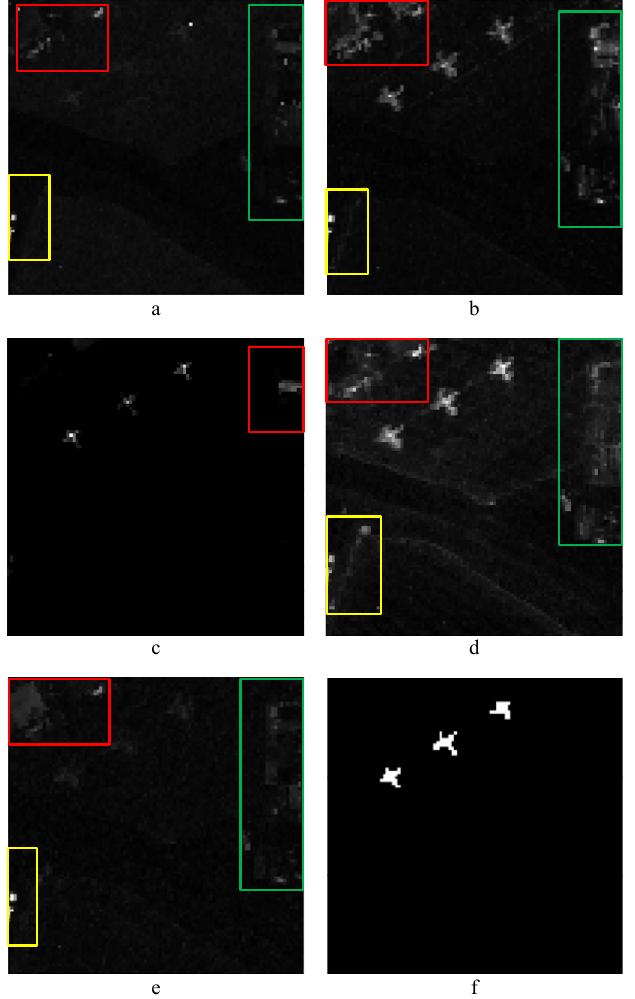
Figure 5. Detection results of ( a ) GRX, ( b ) FEE, ( c ) FEBPAD, ( d ) LSAD-CR-IDW, ( e ) LRSRD, and ( f ) Triple-S for AVIRIS San Diego airport dataset.